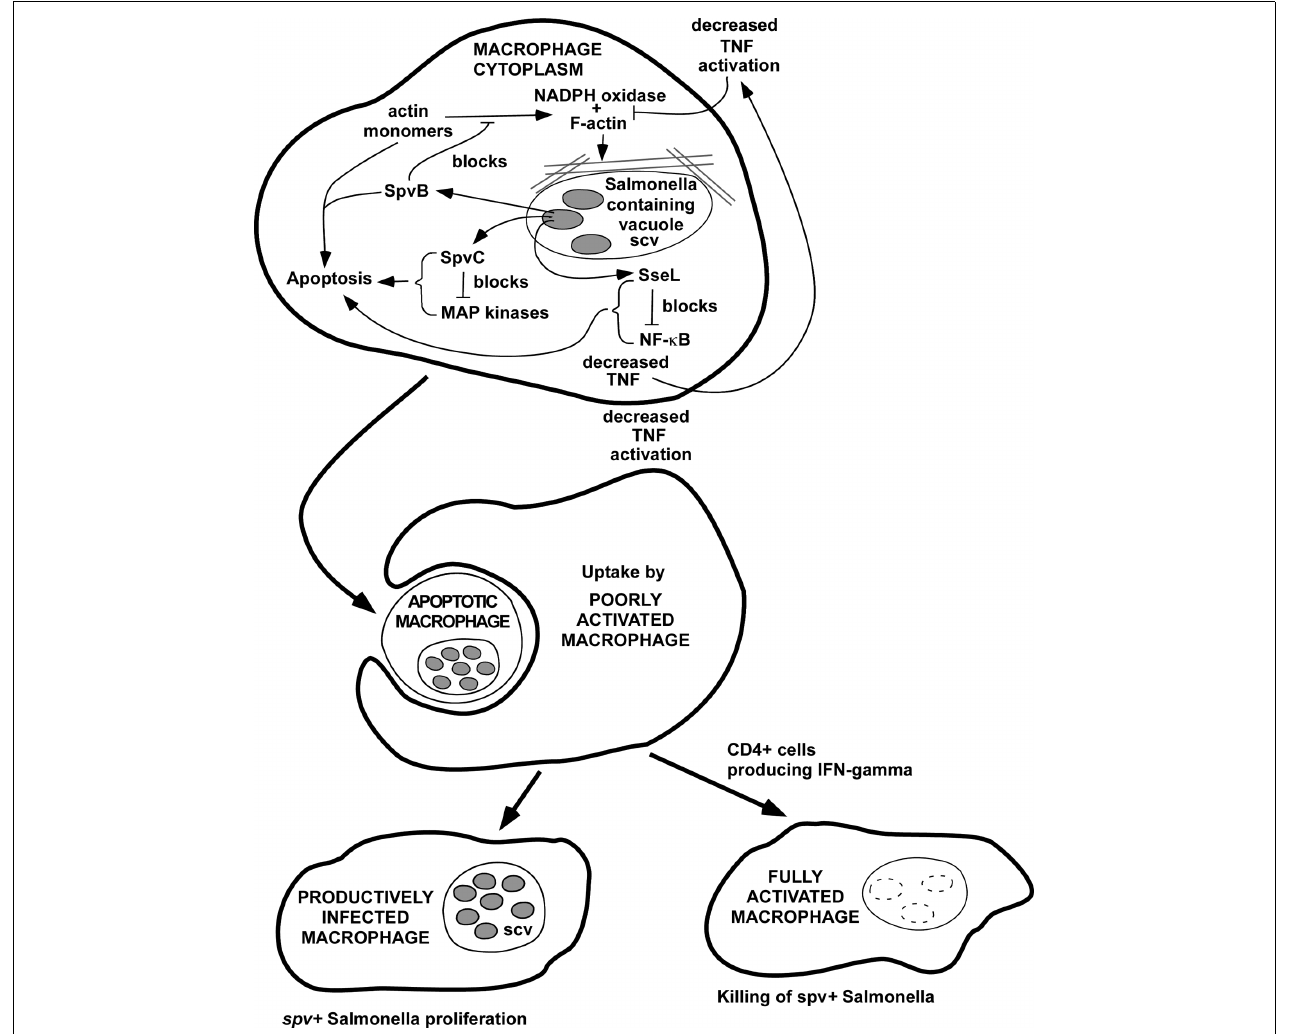
gentamicin, and phagocytosis of extracellular bacteria by neutrophils, are not able to terminate infections with Salmonella strains that express spv genes. This model would provide an explanation for the experimental and clinical evidence that CD4T cells and IFN-gamma are required to control infections due to spv + Salmonella , likely involving macrophage activation and killing of intracellular